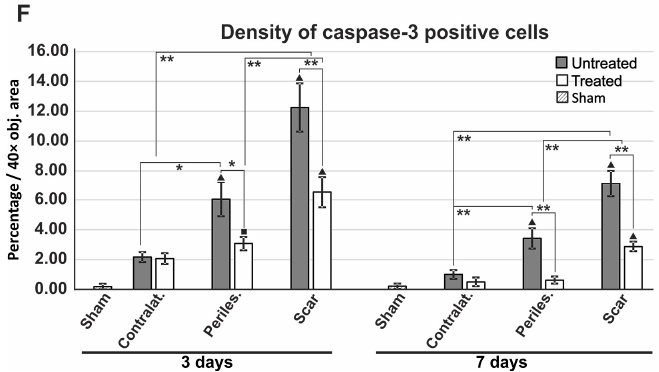
Figure 7. Assessment of apoptosis by counting cleaved caspase-3-positive cells. ( A ) Low-magnification overview of cleaved caspase-3 expression pattern in a 3-day untreated MCAO animal. ( B ) Representative perilesional higher-magnification RGB images decomposed as pure DAB and hematoxylin signals after spectral unmixing ( C – E ) showing that only cells presenting immunoreactivity in the nucleus (arrowheads) were counted for the analysis, while cells immunopositive in the cytoplasm only were rejected (arrows); ( F ) Direct counting revealed lower apoptosis levels for treated animals in the ipsilateral perilesional hemisphere and the scar areas at 3 days and 7 days after injury (* p < 0.05, ** p < 0.01; ■ p < 0.05 and ▲ p < 0.01 (for pathological regions versus sham animals), using a one-way ANOVA followed by a post hoc Fisher’s LSD test, n = 5–6/group). The differences between 3 and 7 days are not included for reasons of clarity. Data are expressed as the means ± SEM. Scale bars in the micrographs represent 1 mm ( A ), and 20 µm ( B – E ). At 3 days survival time, there was a markedly lower number of cleaved caspase-3-positive cells in the TGN-020-treated animals for both perilesional (3.06 ± 0.44%) and glial scar (6.533 ± 1.044%) regions compared to untreated animals (6.04 ± 1.14%; p < 0.05, and 12.25 ± 1.61, p < 0.001) (Figure 7F). This difference was also conserved in the same two regions between the treated (0.62 ± 0.23%; 2.87 ± 0.31%) and untreated 7-day survival animals (3.41 ± 0.68%, p < 0.001; and 7.12 ± 0.87, p < 0.001), even